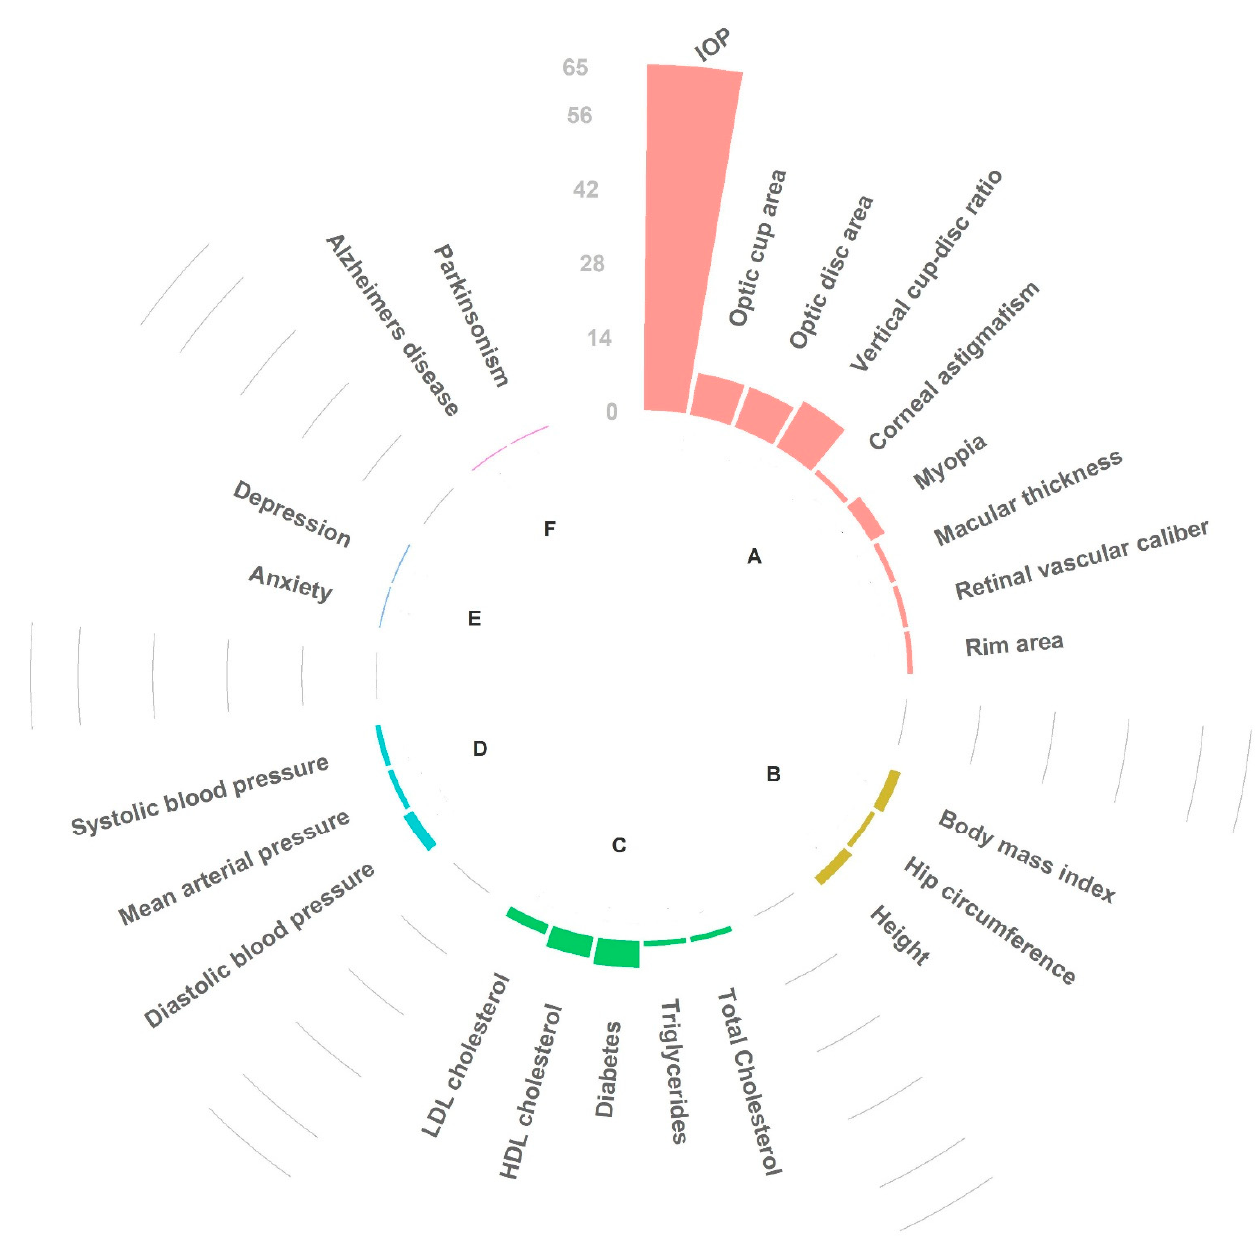
Figure 6. Circular barplot: each bar shows the number of linked SNPs (LD r 2 > 0.80) having pleiotropic effects between POAG-associated loci and six phenotypic categories. A: optic parameters and other eye problems; B: anthropometry-related traits; C: lipids and type 2 diabetes; D: blood pressure; E: psychiatric disorders; F: neurodegenerative disorders.